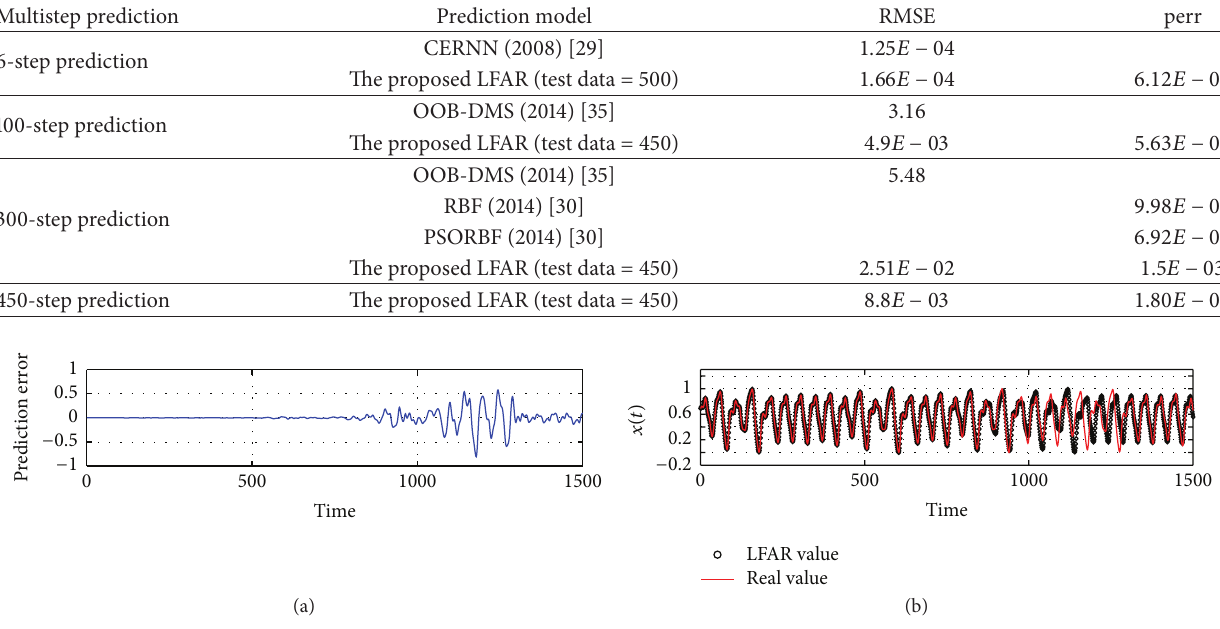
Figure 6: Results of Mackey-Glass time series: (a) and (b) multistep prediction errors and values, respectively.